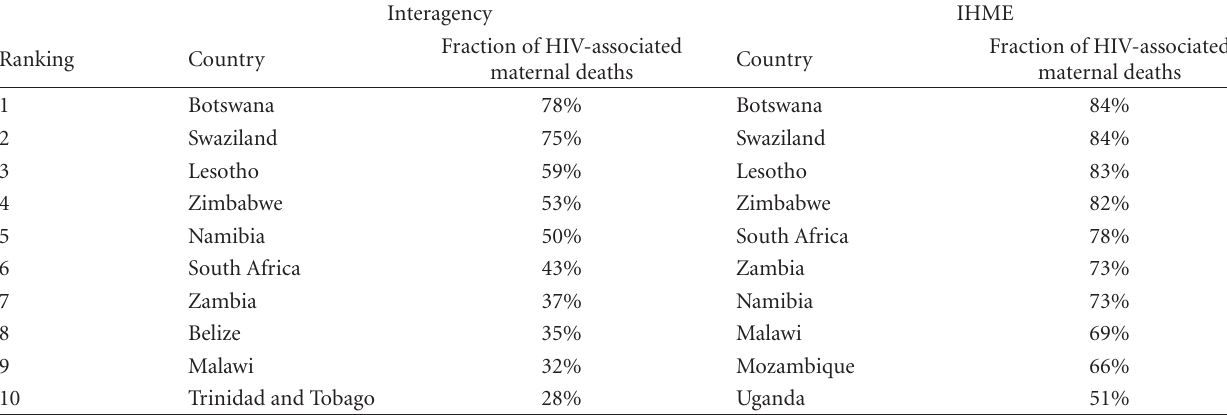
Table 3: 10 Countries with the highest fraction of HIV-associated maternal deaths, 2008, by